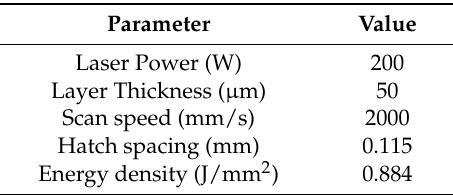
Figure 1. Laser scanning of stainless steel 316L using selective laser melting (SLM) (right). Orientation of the samples and sloping angle (top left) and scanning laser types: ( a ) chessboard, ( b ) meander, ( c ) stripes (down left). Table 1. Process parameters for Stainless steel 316L. Table 1. Process parameters for Stainless steel